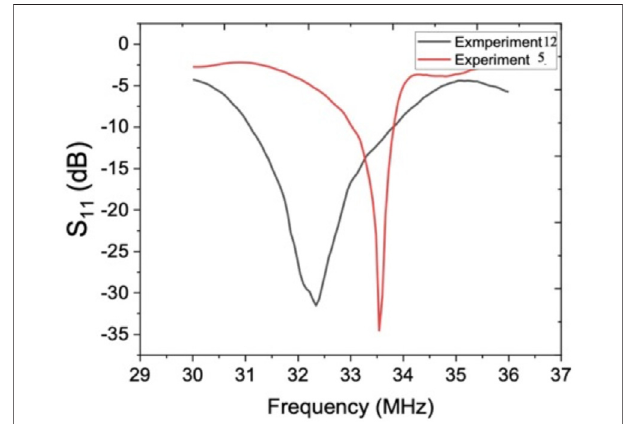
FIGURE 12 | Frequency response of experiment numbers 12 and